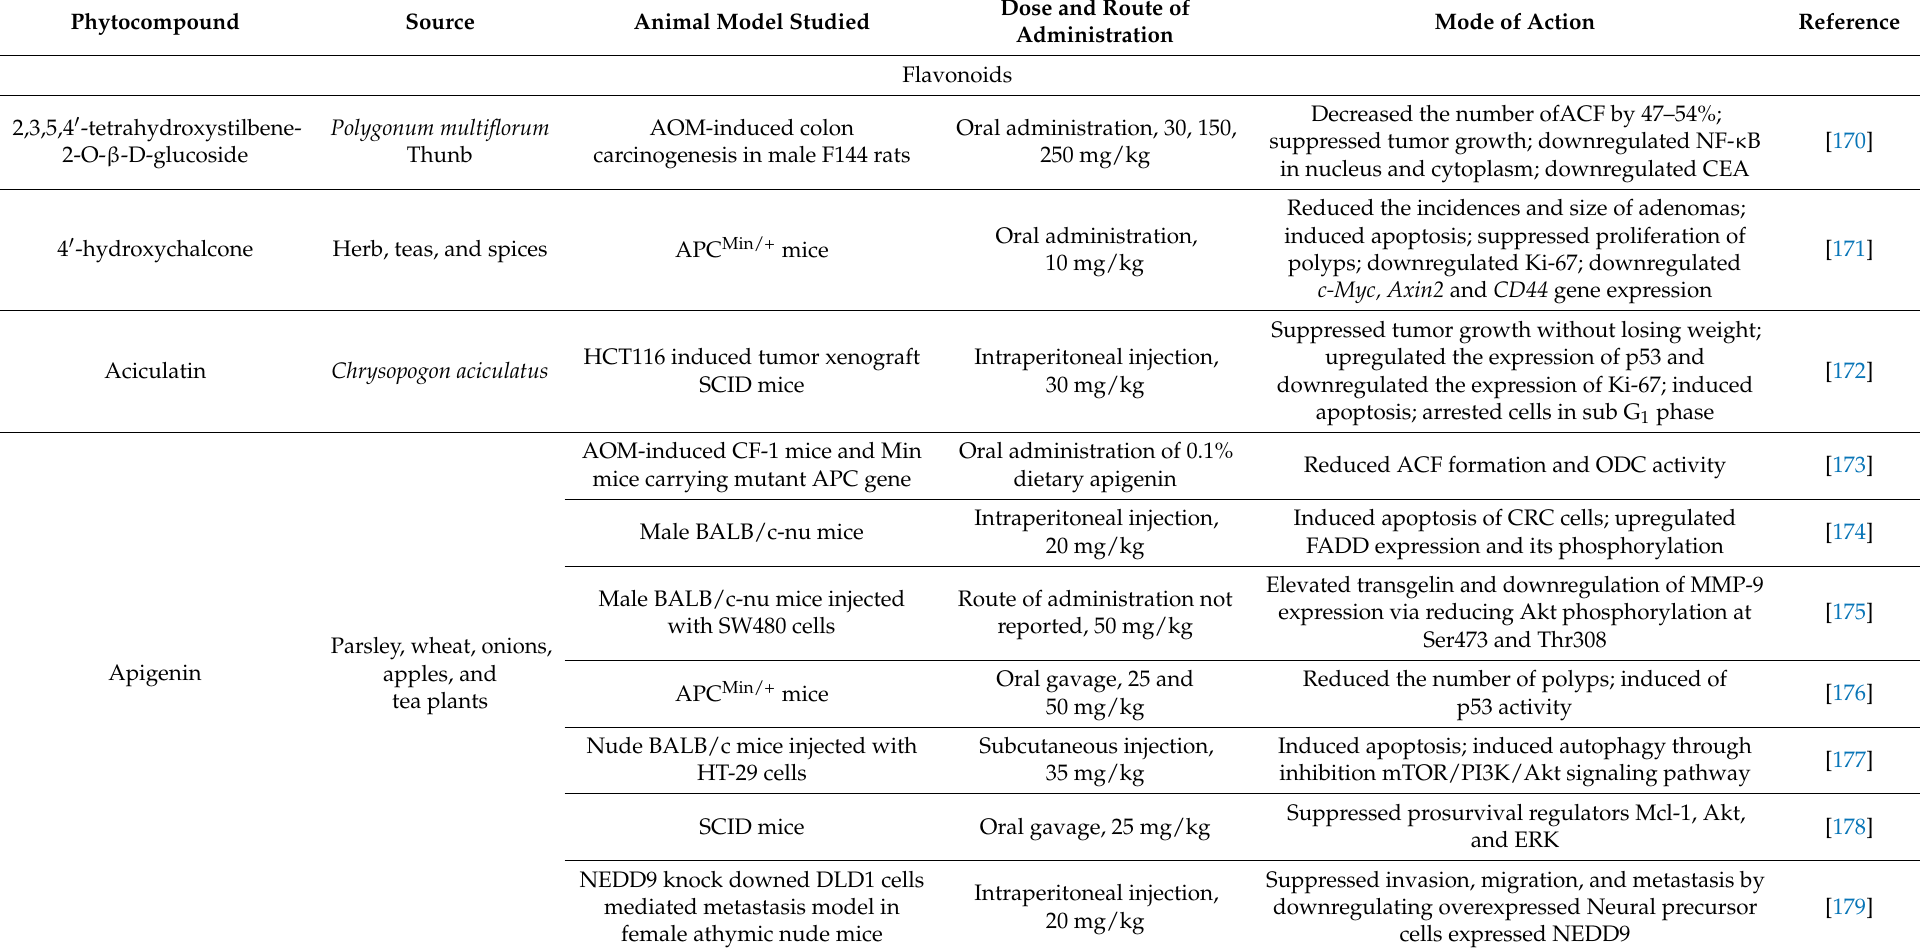
Table 3. Anti-CRC effects and mechanisms of action of phenolic compounds based on in vivo